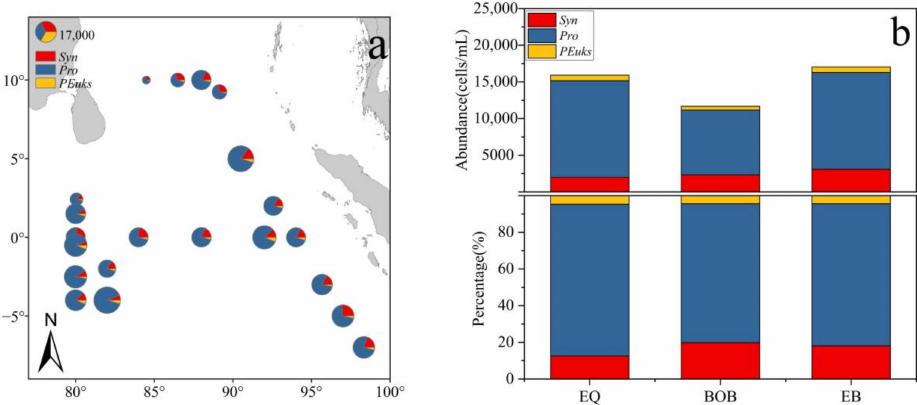
Figure 7. Average cell abundance and percentage of pico. ( a ) Average cell abundance and percentage of every station. ( b ) Average cell abundance and percentage of different regions. Bay of Bengal (BOB), the Equator (EQ), and the eastern border of the Indian Ocean near Sumatra (EB). Prochlorococcus ( Pro ), Synechococcus ( Syn ), and Picoeukaryotes ( PEuks